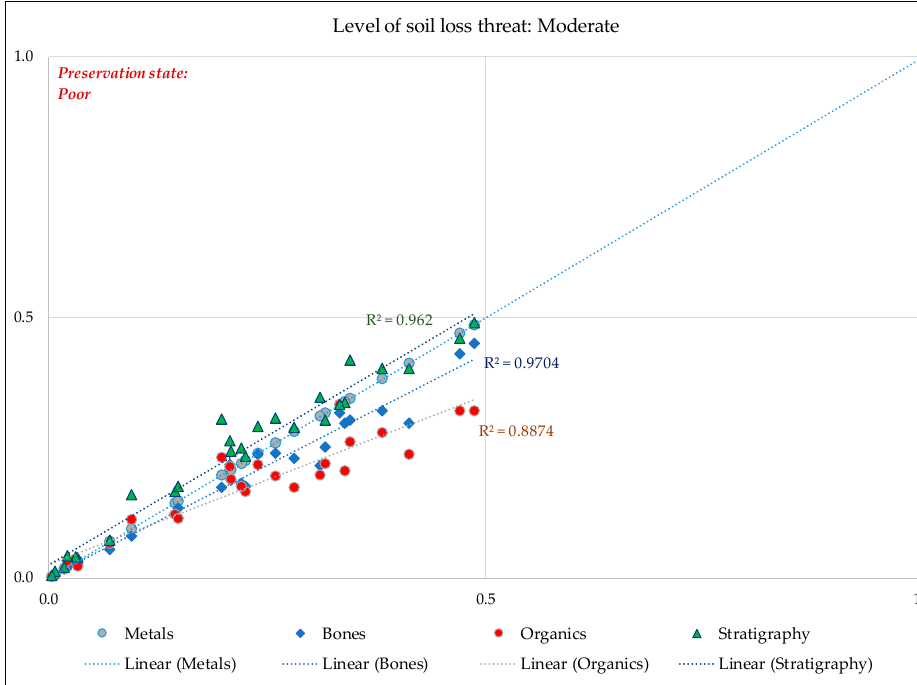
Figure 11. Correlation of the different types of subsurface objects (metals, bones, organics, and stratigraphy) between areas characterized as low for soil-loss threat: Metals objects were used as the baseline (R = 1). Preservation state is also indicated for areas with different colours (red for poor preservation state, yellow for fair preservation state, and green for good preservation state).